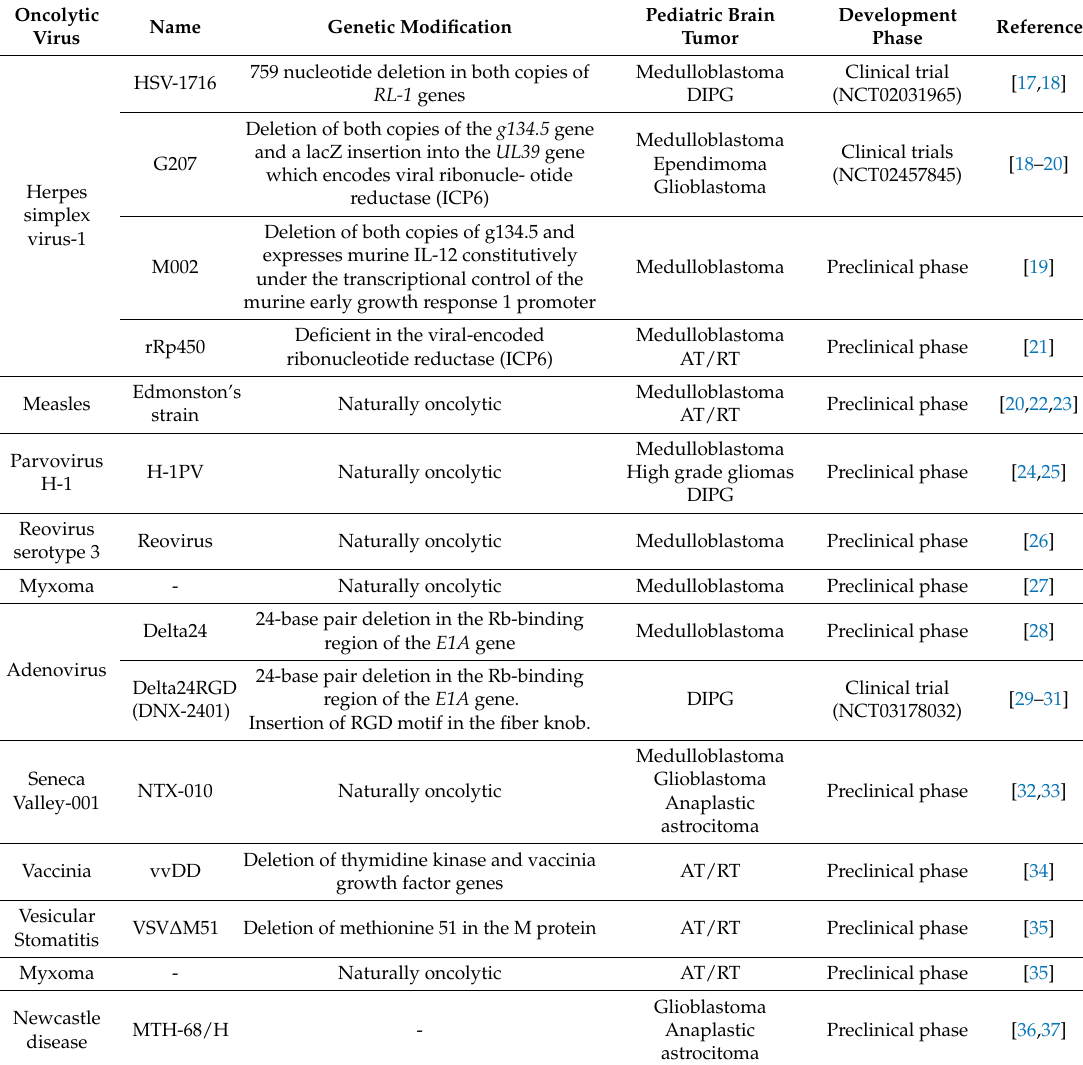
Table 1. Oncolytic viruses evaluated in pediatric brain